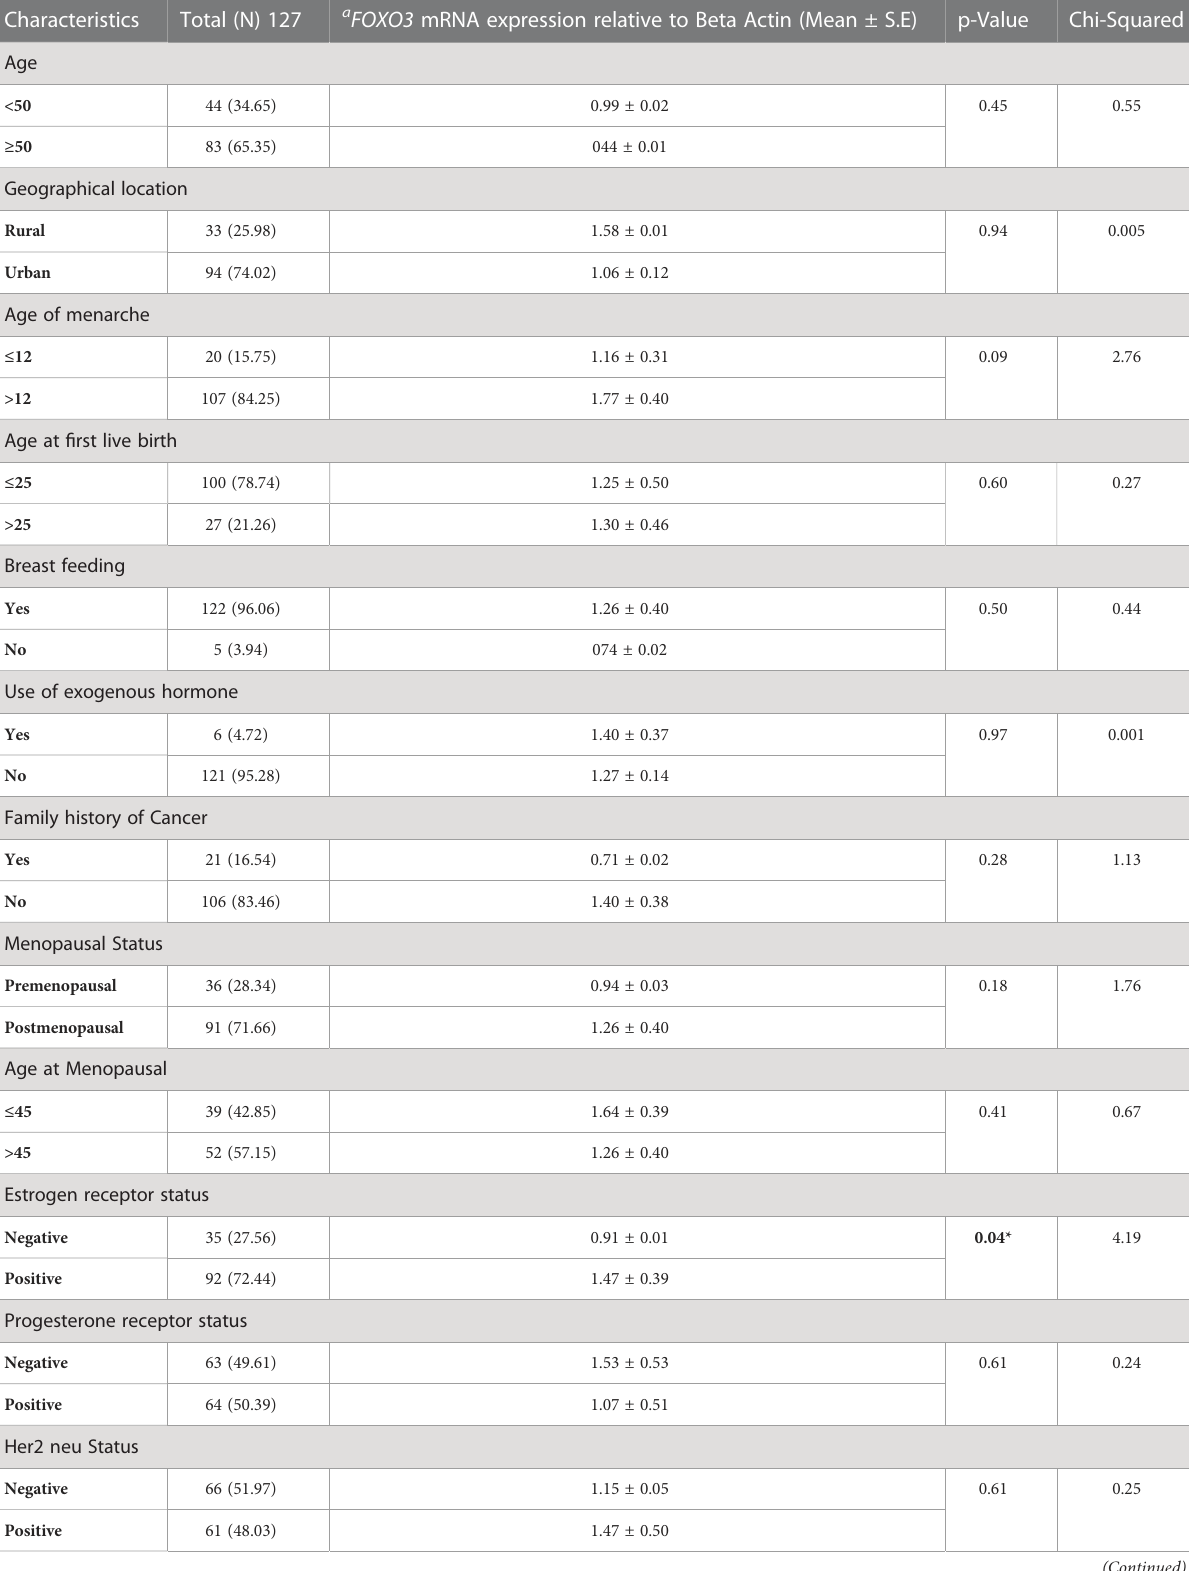
TABLE 2 Correlation study of FOXO3 mRNA expression levels with clinical parameters of breast cancer case.